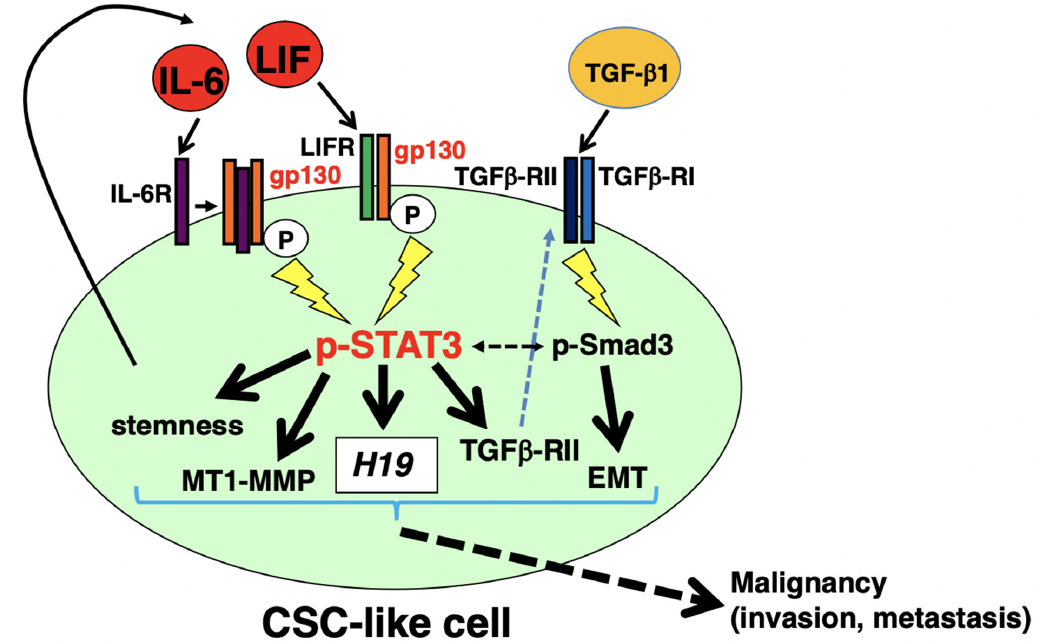
Figure 9. Schematic representation of autocrine/paracrine IL-6 or the LIF/gp130/STAT3 pathway in PDAC sphere cells. In PDAC sphere cells in which CSCs are enriched (CSC-like cells), binding of autocrine/paracrine IL-6 or LIF to each receptor (IL-6R or LIFR, respectively) induces gp130 homodimerization or LIFR/gp130 complex formation to thereby activating JAKs followed by phosphorylation of gp130, ultimately leading to STAT3 activation. This pathway contributes to the maintenance of stemness features and expression of MT1-MMP and TGF β -RII. Expression of TGF β -RII via the gp130/STAT3 pathway affects TGF- β 1/Smad signaling to promote EMT induction. Additionally, p-STAT3 can access the active promoter region of H19 and contribute to its transcription. Therefore, autocrine/paracrine IL-6 or the LIF/gp130/STAT3 pathway in PDAC CSC-like cells is believed to eventually lead to invasion and metastasis, both of which are hallmarks of malignancy. Primers list, Table S2: List of primary antibodies used for immunoblotting, Table S3: Primers list for ChIP assay, Figure S1: Active gp130/STAT3 pathway in other PDAC sphere cells., Figure S2: Active gp130/STAT3 pathway involved in stemness and invasion of PK-1sphere cells., Figure S3: Correla- tion between gp130/STAT3 and TGF/Smad pathway in PK-1 cells., Figure S4: Autocrine/paracrine IL-6 or LIF/gp130/STAT3 pathway regulate H19 expression in PK-1 sphere cells., Figure S5: H19 expression in IL-6- or LIF-stimulated PANC-1 cells; Figure S6: Stable knockdown of gp130 in PANC-1 cells; Figure S7: Western blots.